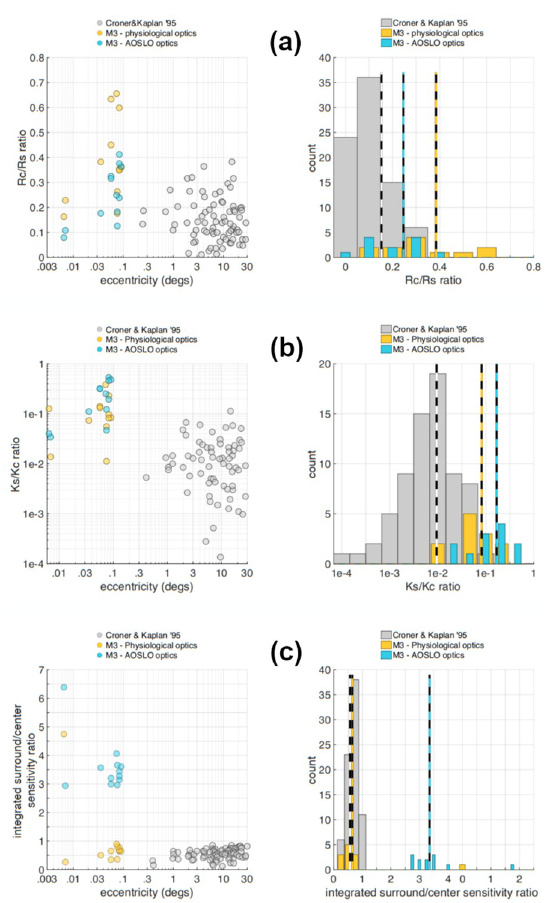
Fig 11. Relationship between our findings in foveal midget RGCs and findings in midget RGCs from earlier studies. Data from Croner & Kaplan [9] is shown in gray, data from M3 using the ISETBio model and physiological optics is shown in yellow, and data from M3 using the AOSLO optics is shown in blue. a. Analysis of Rc/Rs ratio. Left panel: relationship between the Rc/Rs ratio and retinal eccentricity. Right panel: distribution of Rc/Rs. The mean Rc/Rs ratio in the Croner & Kaplan data is 0.15, vs. 0.45 in our foveal RGCs under physiological optics, and 0.32 in our foveal RGCs under AOSLO optics. b. Analysis of Ks/Kc ratio. The mean Ks/Kc ratio in the Croner & Kaplan data is 9.4e-3, vs. 1.1e-1 in our foveal RGCs under physiological optics, and 0.28 in our foveal RGCs under AOSLO optics. c. Analysis of integrated surround-to-center ratio, (Ks/Kc) x (Rs/Rc) 2 . The mean integrated surround-to-center ratio in the Croner & Kaplan data is 0.54, vs. 0.71 in our foveal RGCs under physiological optics, and 3.37 in our foveal RGCs under AOSLO